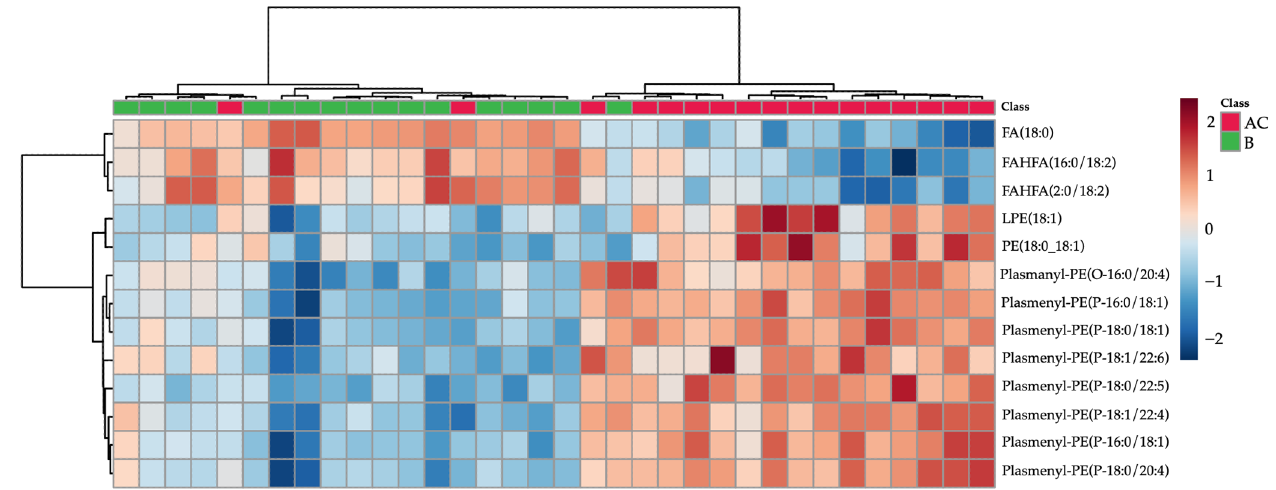
Figure 2. Hierarchal cluster analysis (HCA) heatmap based on lipids with t -test p -value < 0.05 and partial least squares discriminant analysis variable importance on projection (PLS-DA VIP) score > 1 (lipids characteristics shown in Table 1). Subacute patient samples are colored green, follow-up samples in red.